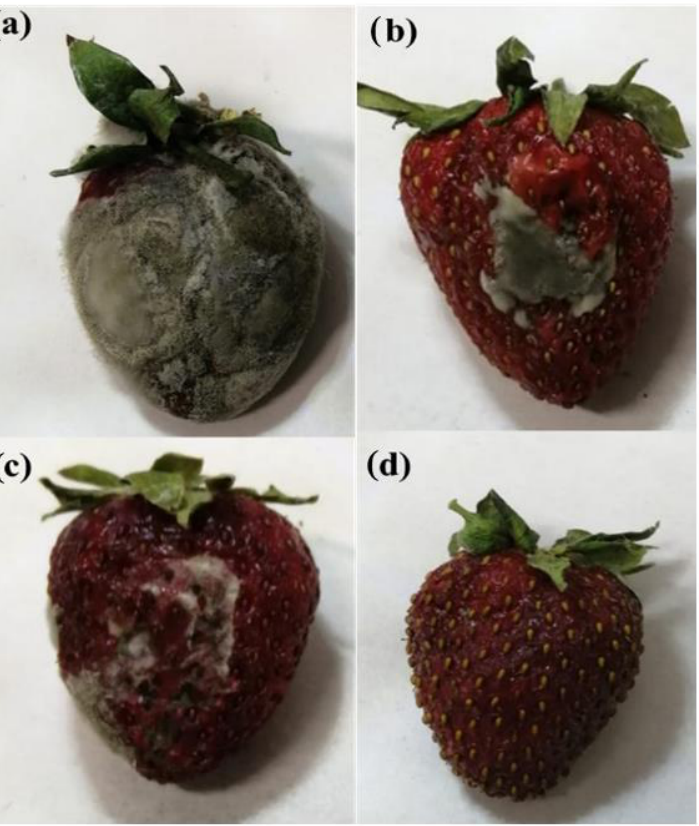
Figure 9. Fresh strawberry: ( a ) uncoated; ( b ) coated with P-H 80 G 20 ; ( c ) coated with P-H 70 G 30 , and ( d ) coated with P-H 50 G 50 after 10 days of storage at room temperature, RH = 60%.